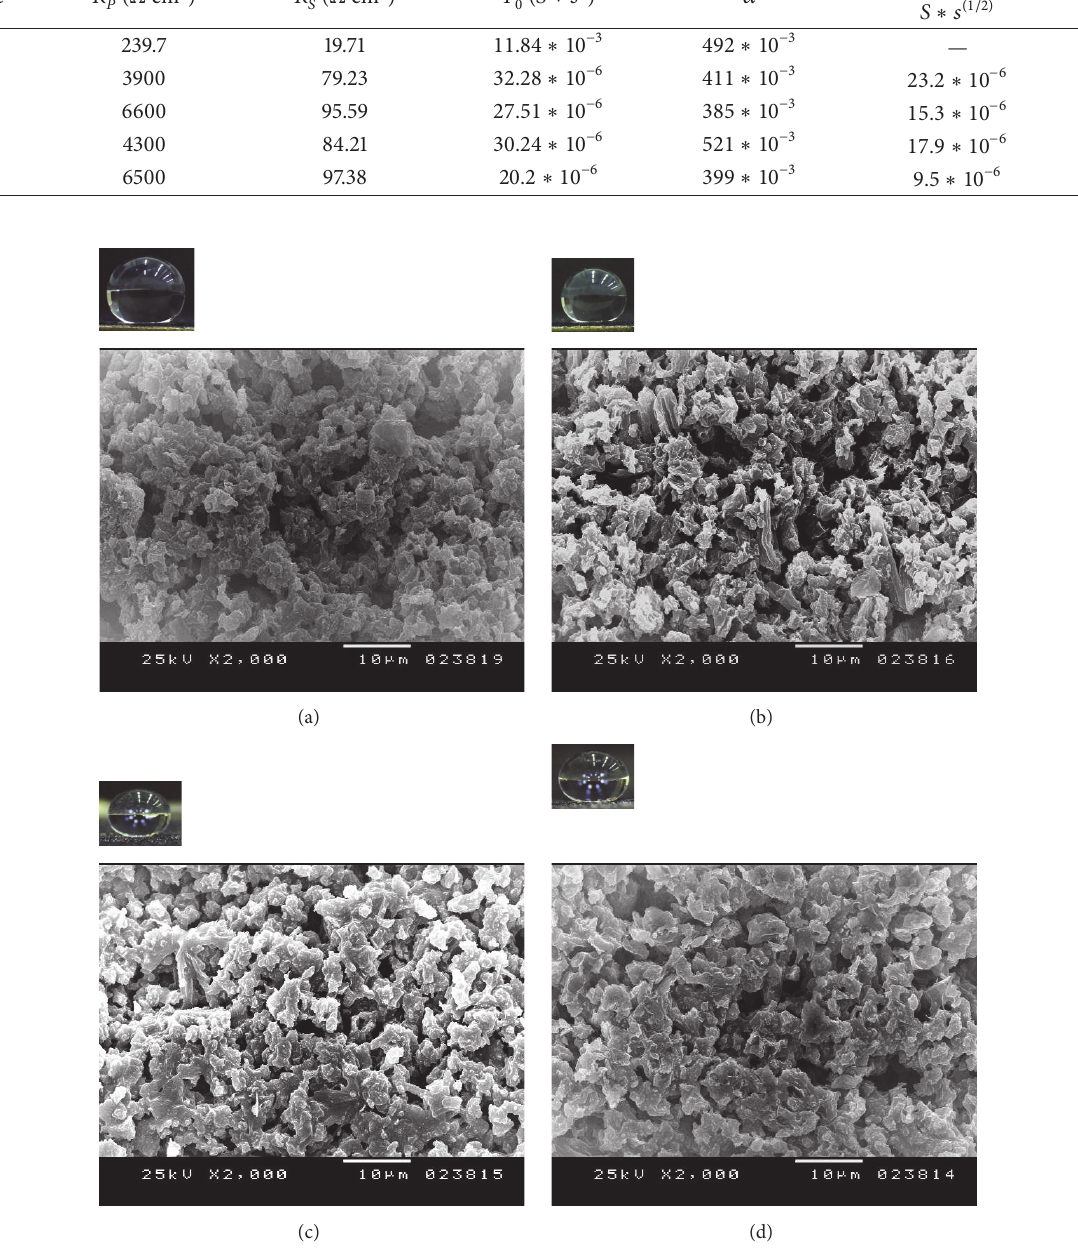
Figure 6: SEM images of modified FG on copper alloy surfaces (a) VFG 10, (b) VFG 30, (c) DFG 30 before corrosion, and (d) DFG 30 after